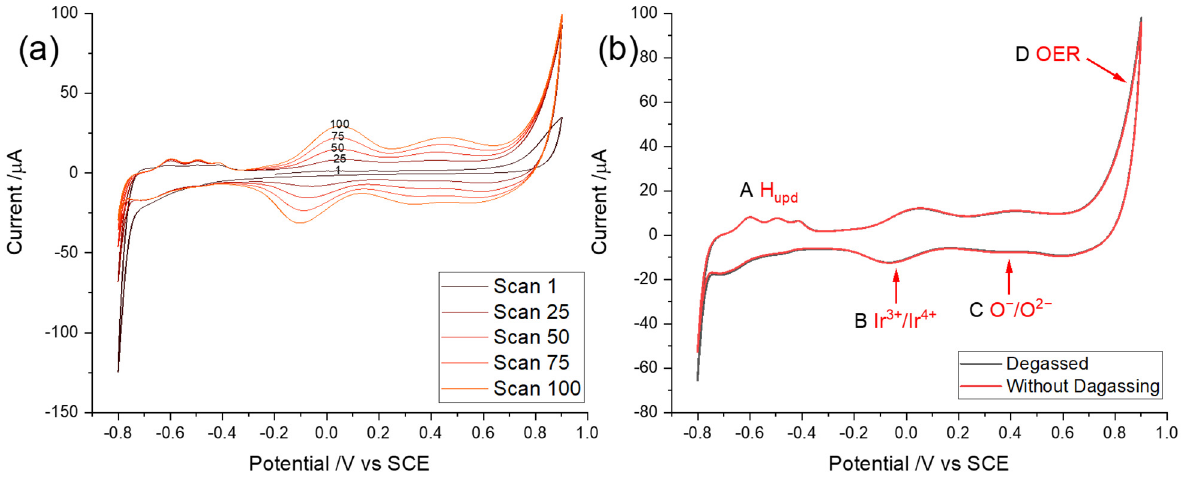
Figure 2. ( a ) Cyclic voltammograms showing the activation of an Ir wire at a scan rate of 0.5 Vs − 1 for multiple cycles. The start potential was − 0.2 V vs. SCE in air-saturated synthetic seawater with pH = 8.1. ( b ) Overlaid 40th cyclic voltammograms in synthetic seawater with pH = 8.1 using an Ir wire at a scan rate of 0.5 Vs − 1 ; degassed: black line, without degassing: red line.